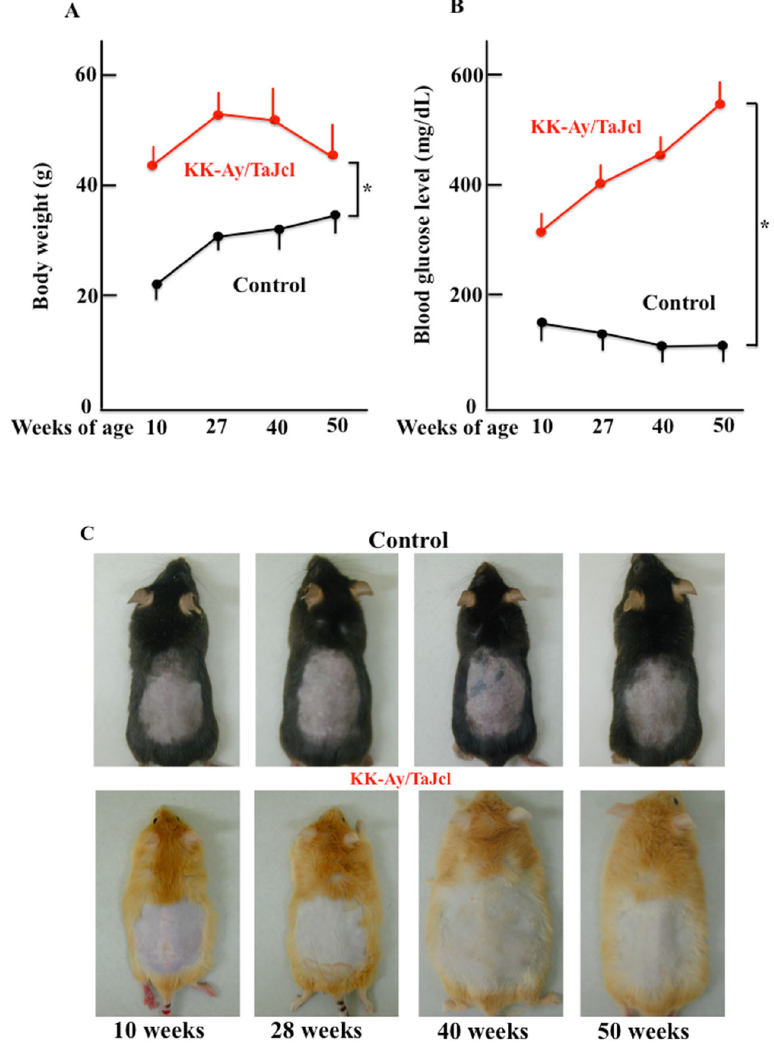
Figure 1. Effect of aging on body weight ( A ), blood glucose levels ( B ), and skin condition ( C ) in KK ‐ Ay/TaJcl mice. Values are expressed as the mean ± SD of five animals. * p < 0.05. Control: C57BL/6j mice.